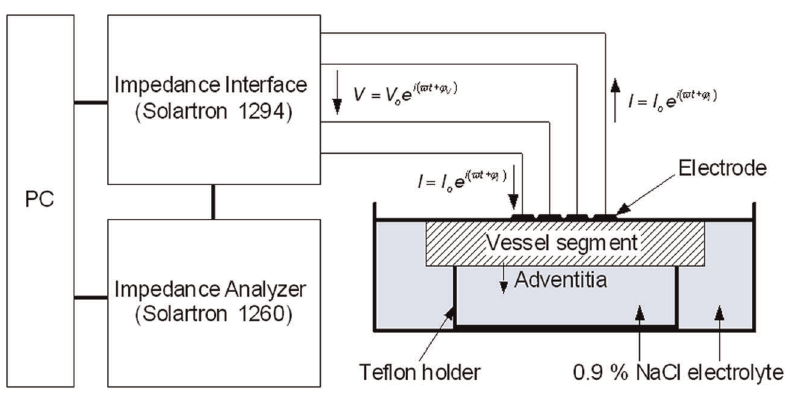
Figure 1. Experimental setup of the impedance measurement system.